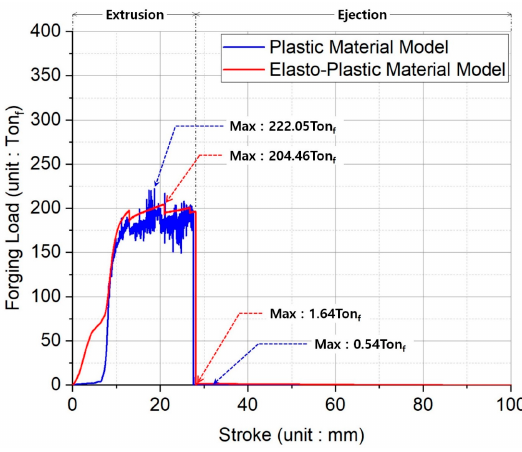
Figure 12. Forging load prediction required for forward extrusion and ejection.